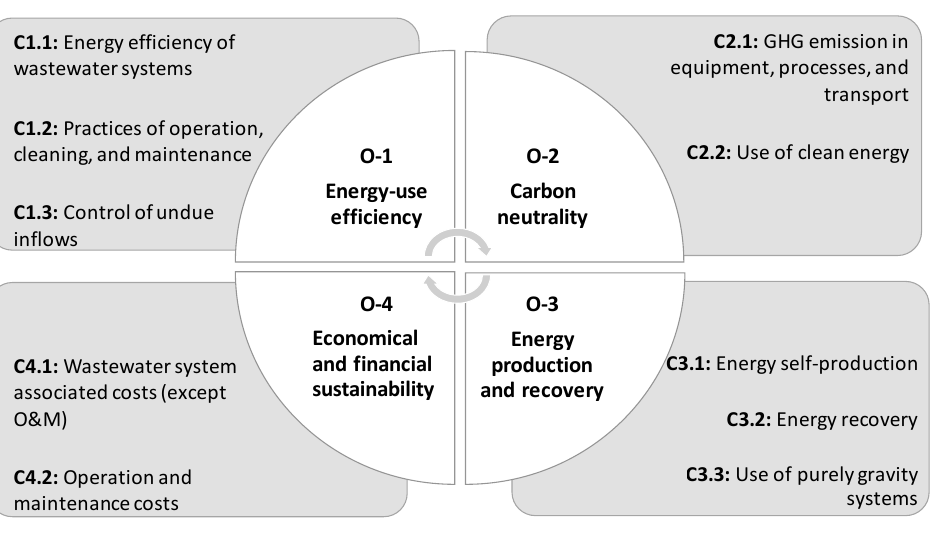
Figure 3. PAS for energy efficiency in wastewater systems objectives and criteria. Table 2. Complete PAS: objectives, criteria, metrics, and reference values.